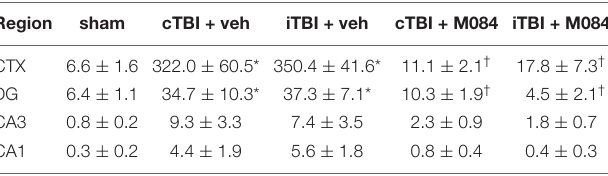
TABLE 3 | cFos+ neuron counts in regional image field of view for sham and TBI TRAP mice 7 days postprocedure.